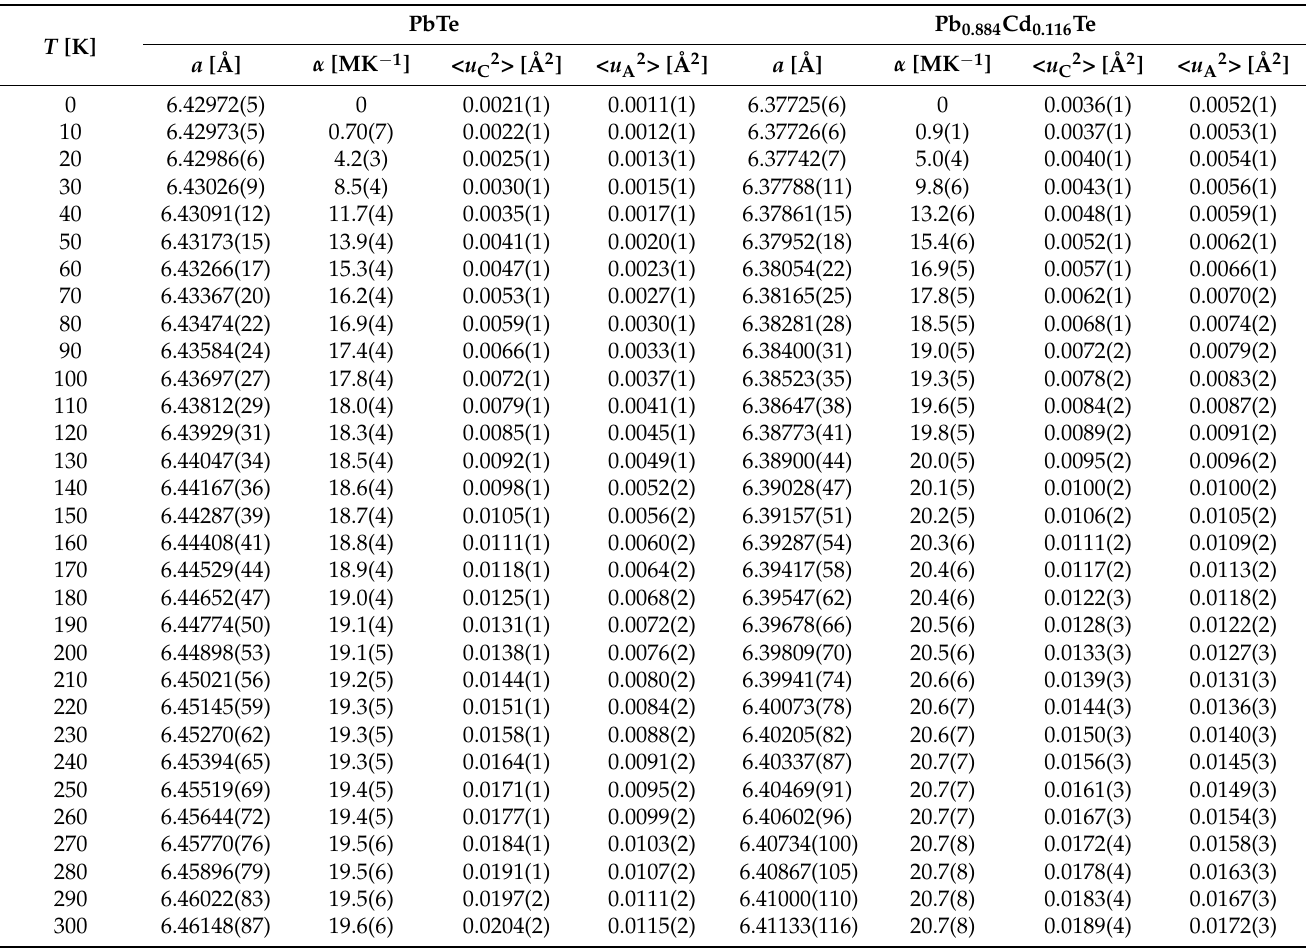
Table A2. Present values of a ( T ), α ( T ) and < u 2 >( T ), modeled by Equations (1) and (2) for PbTe and Pb 0.884 Cd 0.116 Te.